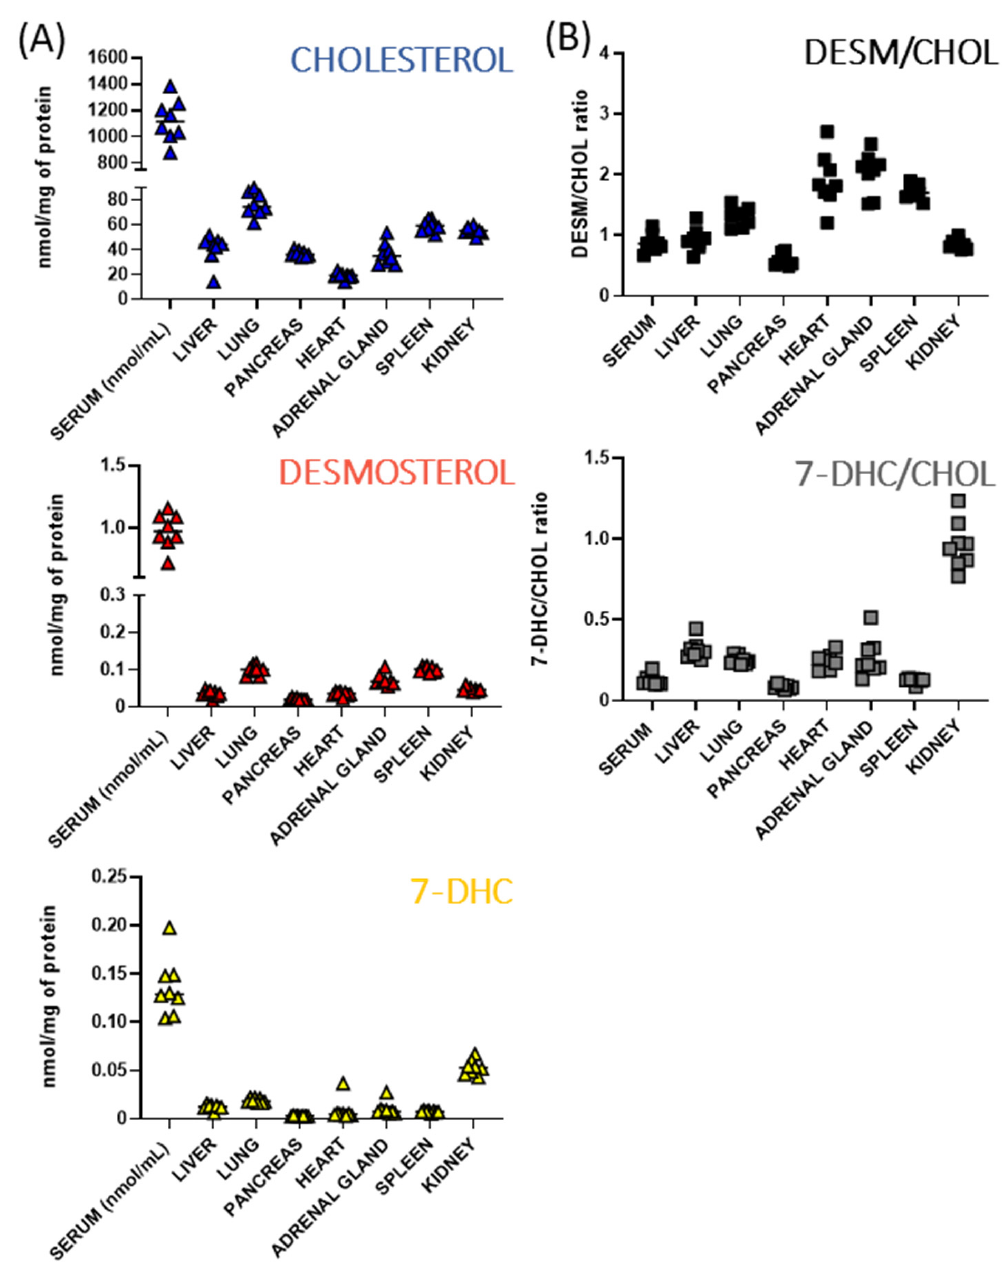
Figure 3. Sterol levels across serum samples and seven peripheral organs of adult mice. ( A ) Y-axis represents sterol levels (CHOL, DES, and 7-DHC), X axis represents sample types. Each symbol represents a single LC-MS/MS measured sample. ( B ) DES/CHOL and 7-DHC/CHOL ratios across the investigated organs and serum samples. Note the sterol content variability across the serum and examined organs.